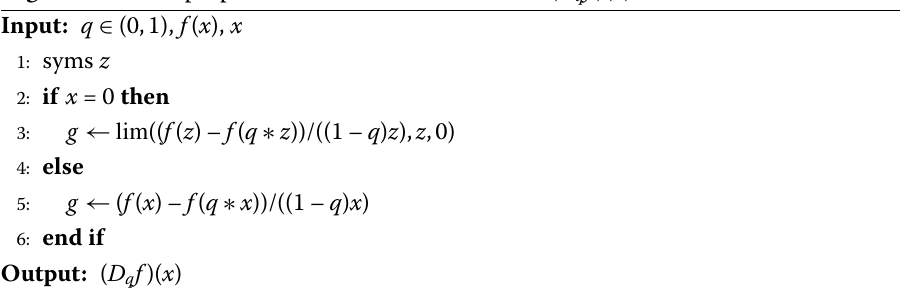
Algorithm 3 The proposed method for calculation of ( D q f )( x